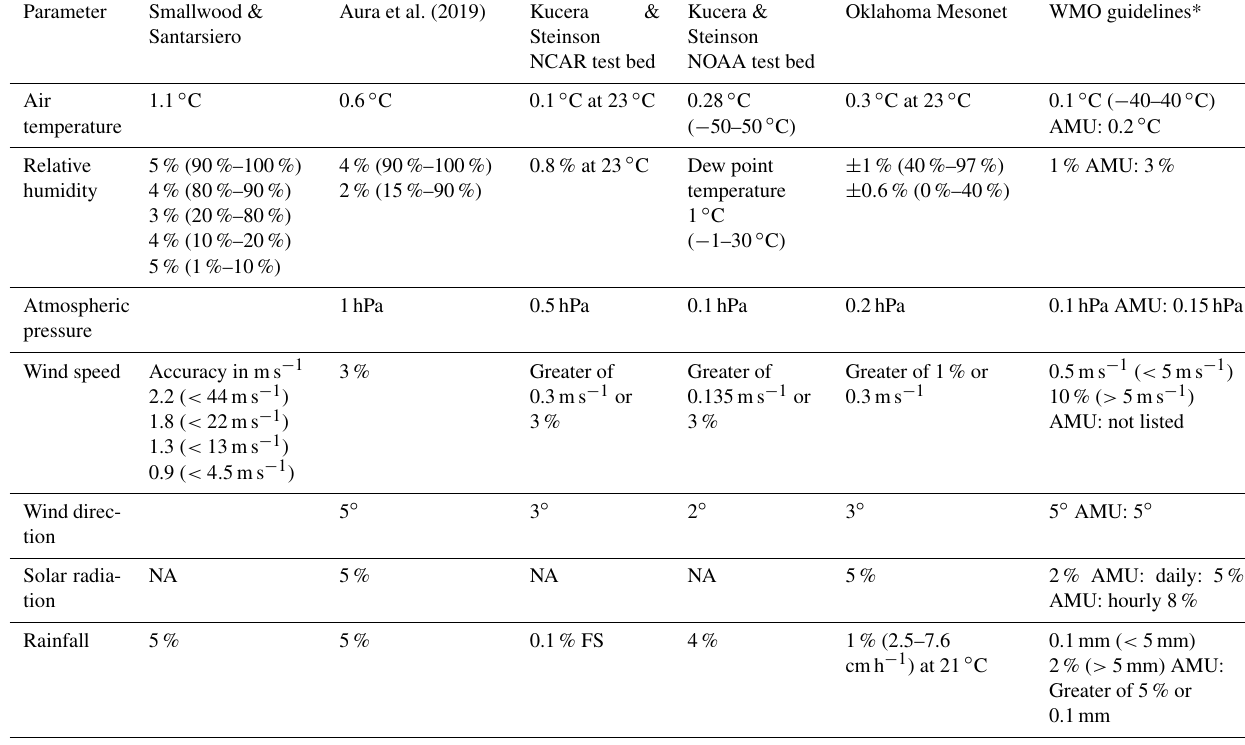
Table 3. Summary of reference instrument accuracy used in 3D-PAWS comparison studies, including requirements from the WMO Guide to Instrument and Methods of Observation – Volume 1 Annex 1.A. (WMO,